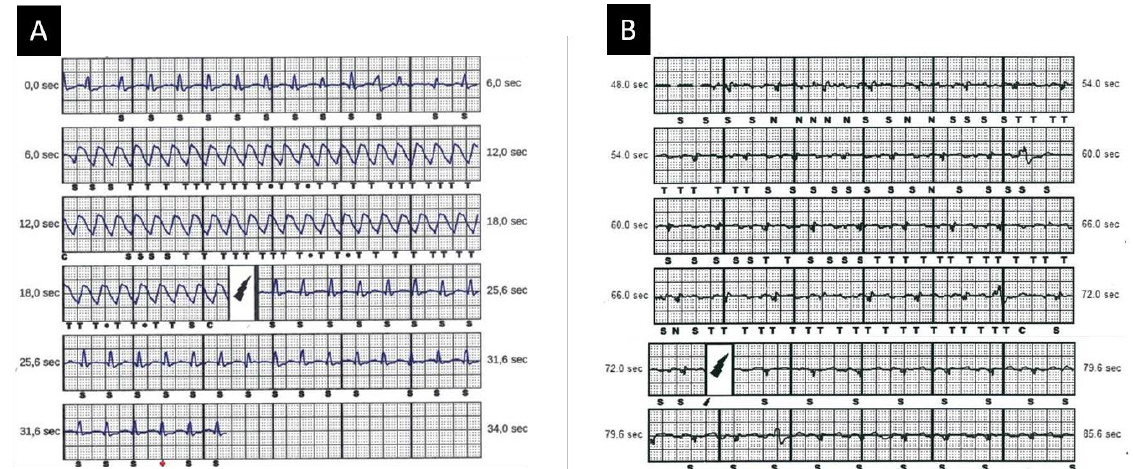
Figure 5. Appropriate and inappropriate S-ICD shocks. ( A ) S-ICD stored electrogram showing appropriately detected and treated ventricular arrhythmia episode. ( B ) S-ICD stored electrogram of inappropriate shock due to P/T-wave oversensing during effort. S-ICD = subcutaneous implantable cardioverter defibrillator. Modified with permission from Migliore et al.